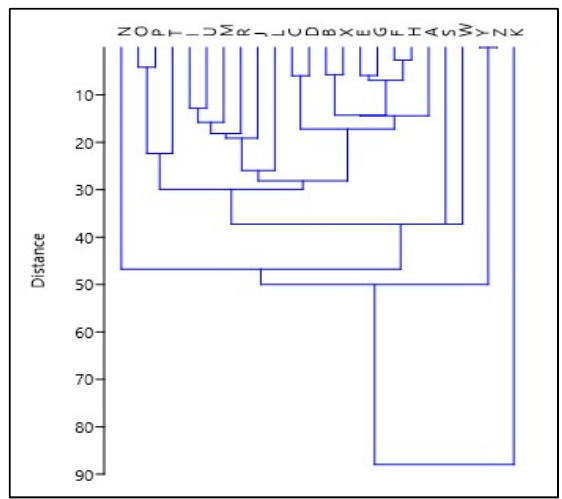
Figure 2. Dendrogram showing the results of the hierarchical cluster analysis (codes A–Z according to Table 5).